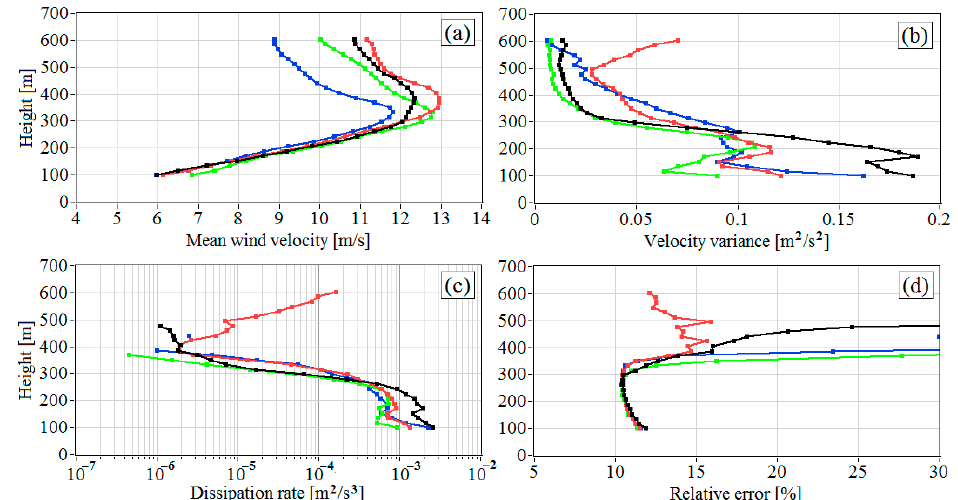
Figure 7. Vertical profiles of the mean wind velocity ( a ), variance of the vertical component of the wind velocity vector ( b ), turbulent energy dissipation rate ( c ), and relative error of lidar estimation of the dissipation rate ( d ) at 00:00 (black curves), 01:00 (red curves), 02:00 (green curves), and 03:00 LT (blue curves) on 11 July 2020. Data are taken from Figure 6.